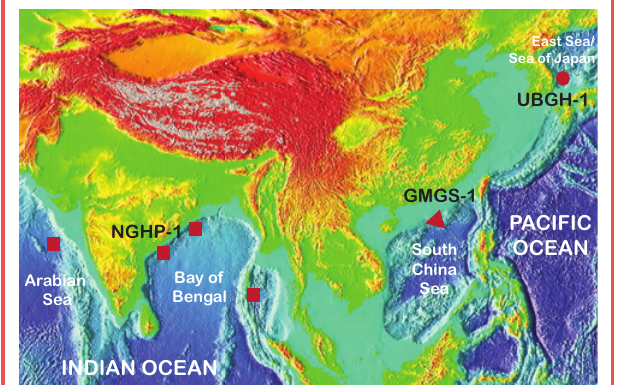
Figure 1. Map of South and Southeast Asia (based on http://www. ngdc.noaa.gov/mgg/image/2minrelief.html) showing the location of recent gas hydrate expeditions NGHP-1 (red squares), GMGS-1 (red triangle), and UBGH-1 (red